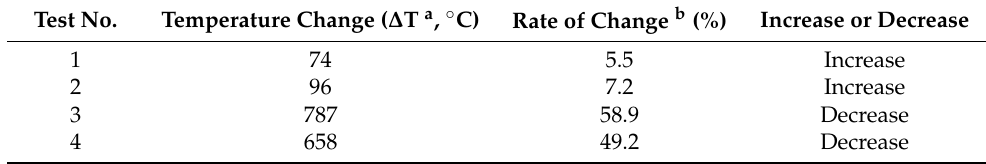
Figure 3. Temperature at the center of the beam spot as a function of time: ( a ) test 1, ( b ) test 2, ( c ) test 3 and ( d ) test 4 (red and blue circle in the figure indicate the end of the 1st track and the start of the 2nd track, respectively). Table 3. Temperature change induced by the corner zone of the beam path.